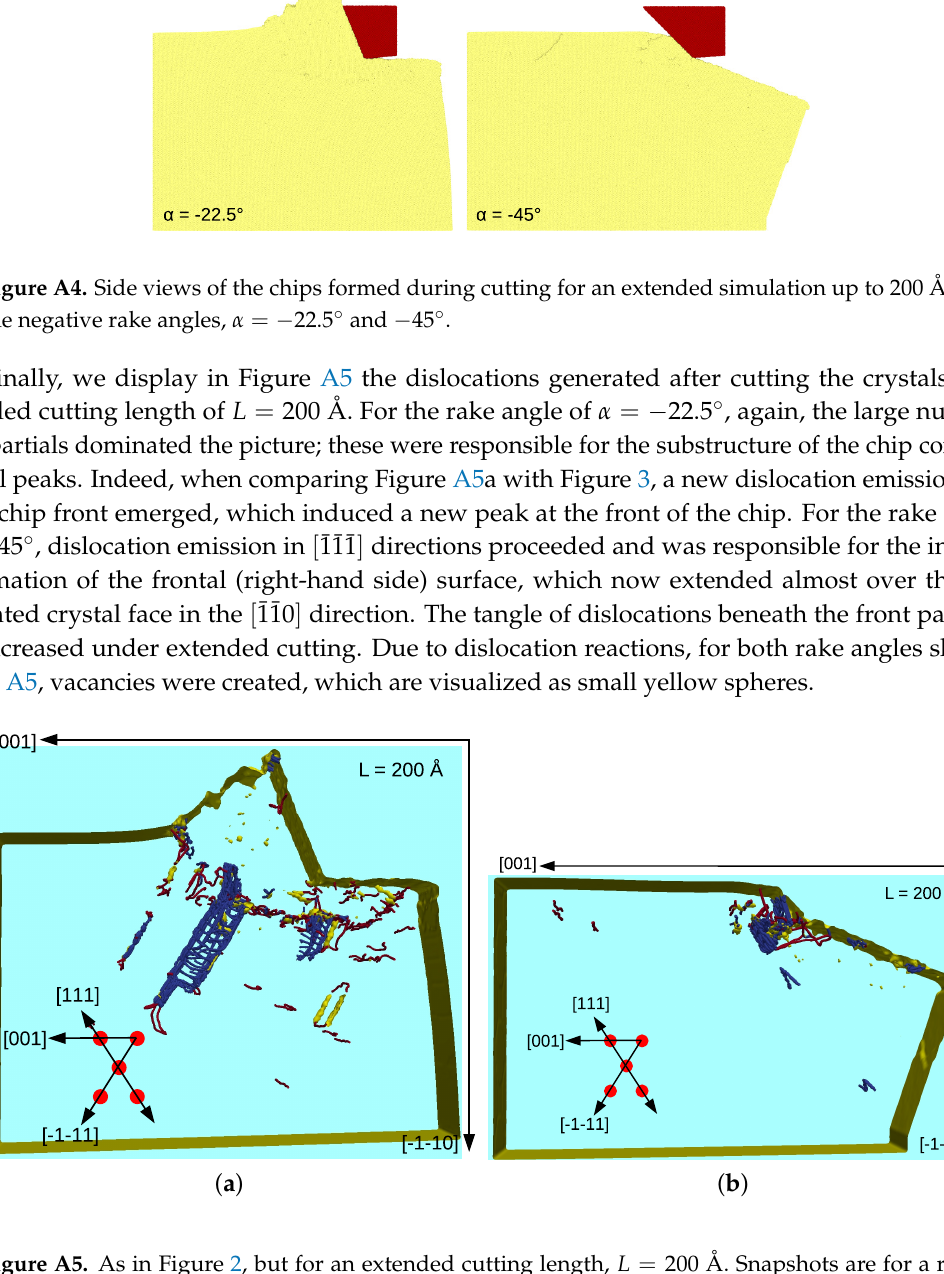
Figure A5. As in Figure 2, but for an extended cutting length, L = 200 Å. Snapshots are for a rake angle of ( a ) α = − 22.5 ◦ and of ( b ) − 45 ◦